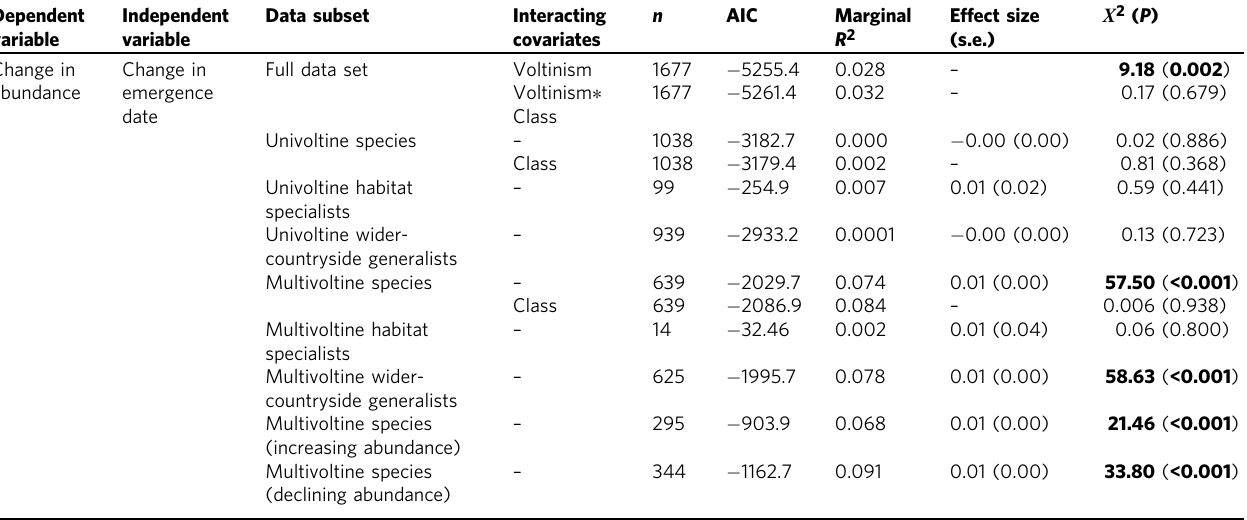
Table 2 Statistical tests of intraspeci fi c relationships between phenology and abundance